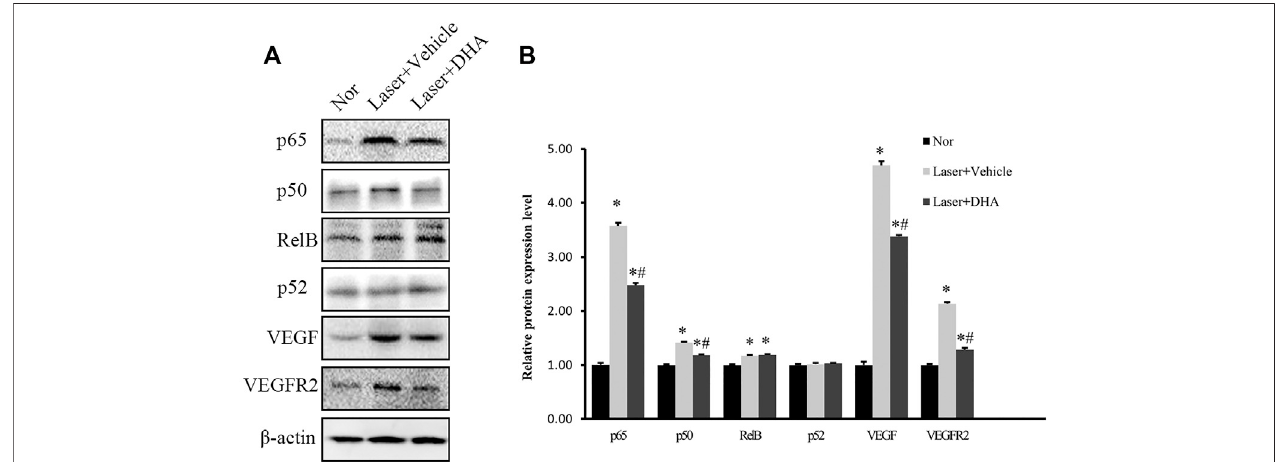
FIGURE 5 | The impact of DHA on the protein expression levels of the NF- κ B family, VEGF, and VEGFR2 in the RPE-choroid complex of a laser-induced CNV mouse model. Mice were intragastrically administered vehicle or DHA once a day for 12 days. (A) The typical Western blot results showed changes in NF- κ B family, VEGF, and VEGFR2 protein expression. (B) The quantitative analysis results demonstrated that the expression levels of NF- κ B p65, NF- κ B1 p50, Rel B, VEGF, and VEGFR2 were markedly increased in the vehicle group compared to the normal control group. DHA signi fi cantly inhibited the expression of NF- κ B p65, NF- κ B1 p50,VEGF,andVEGFR2. n =3experiments;* p < .05vsNor;# p < .05vsLaser+Vehicle;one-wayANOVAfollowedbyTukey ’ stest.CNV:ChoroidalNeovascularization; DHA: